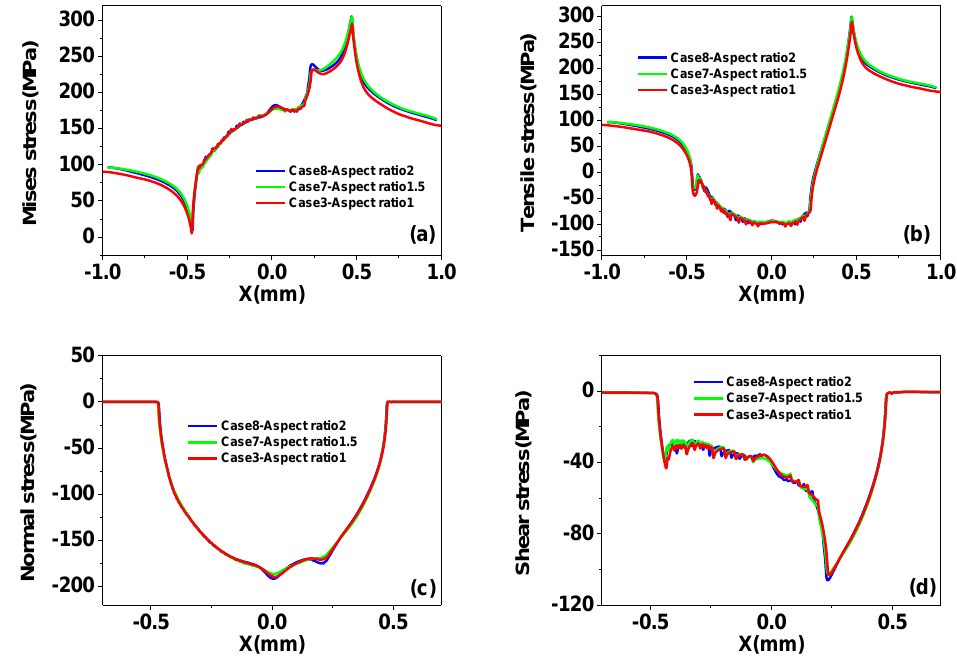
Figure 19. ( a ) Mises stress, ( b ) tensile stress, ( c ) normal stress, ( d ) shear stress distribution on the contact surface for different inclusion shape cases.